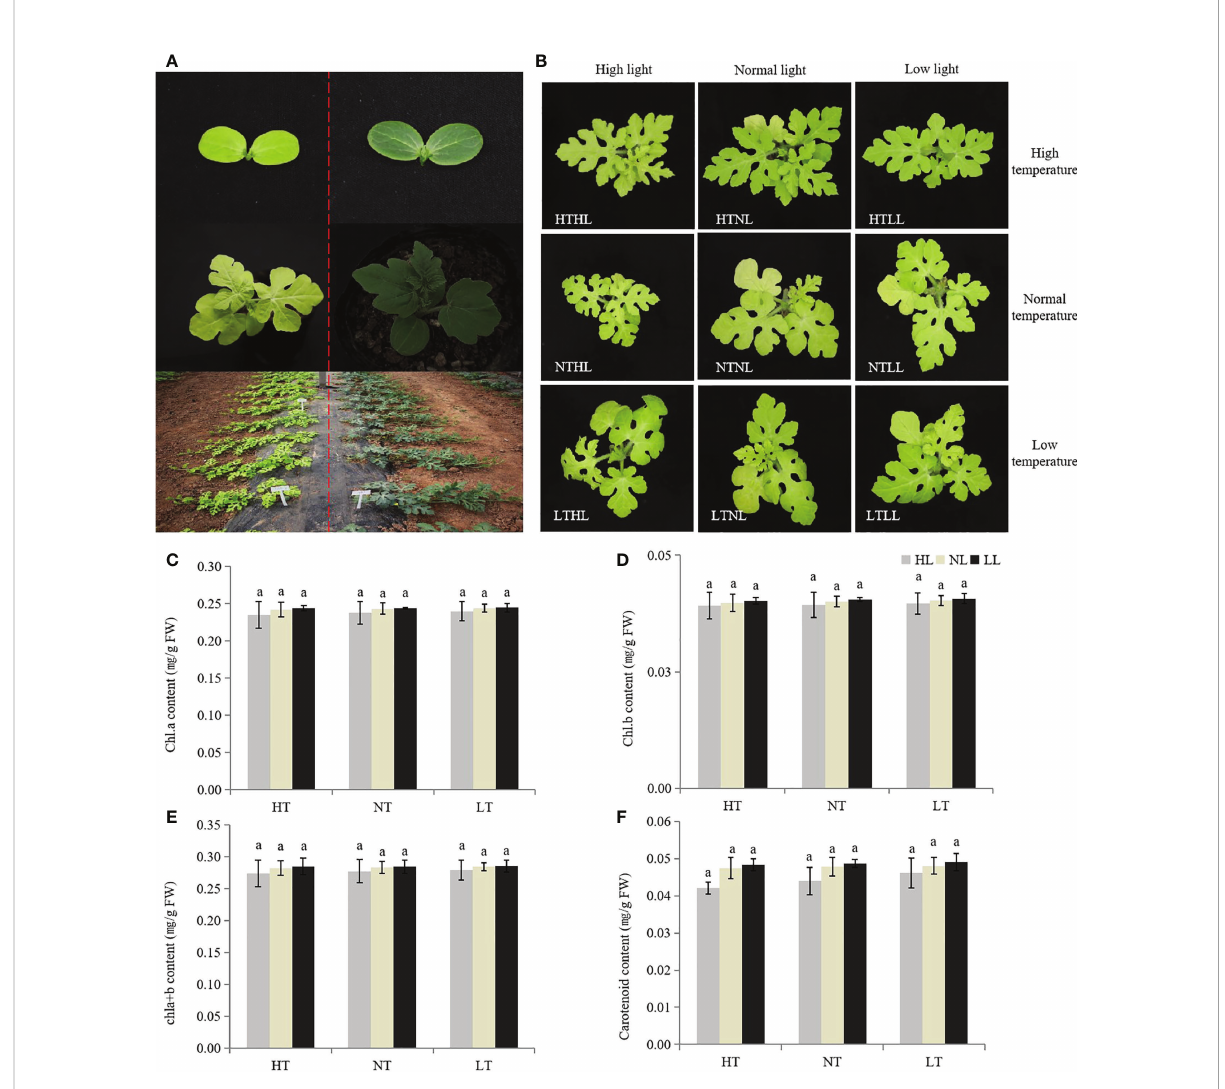
FIGURE 1 Plant phenotypes of w-yl and ZK. (A) Plant phenotypes of w-yl (left) and ZK (right) at different developmental stages. (B) Plant phenotypes of w-yl under different temperature and light intensity. The content of (C) chla, (D) chl b, (E) chla+b and (F) carotenoid under different temperature and light intensity. Small letters represent signi fi cant difference at P<0.05.